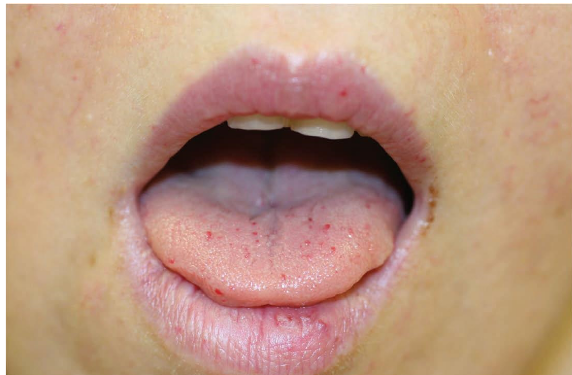
Figure 1: Typical telangiectasia of the skin and mucosa in a patient with HHT. HHT � hereditary hemorrhagic